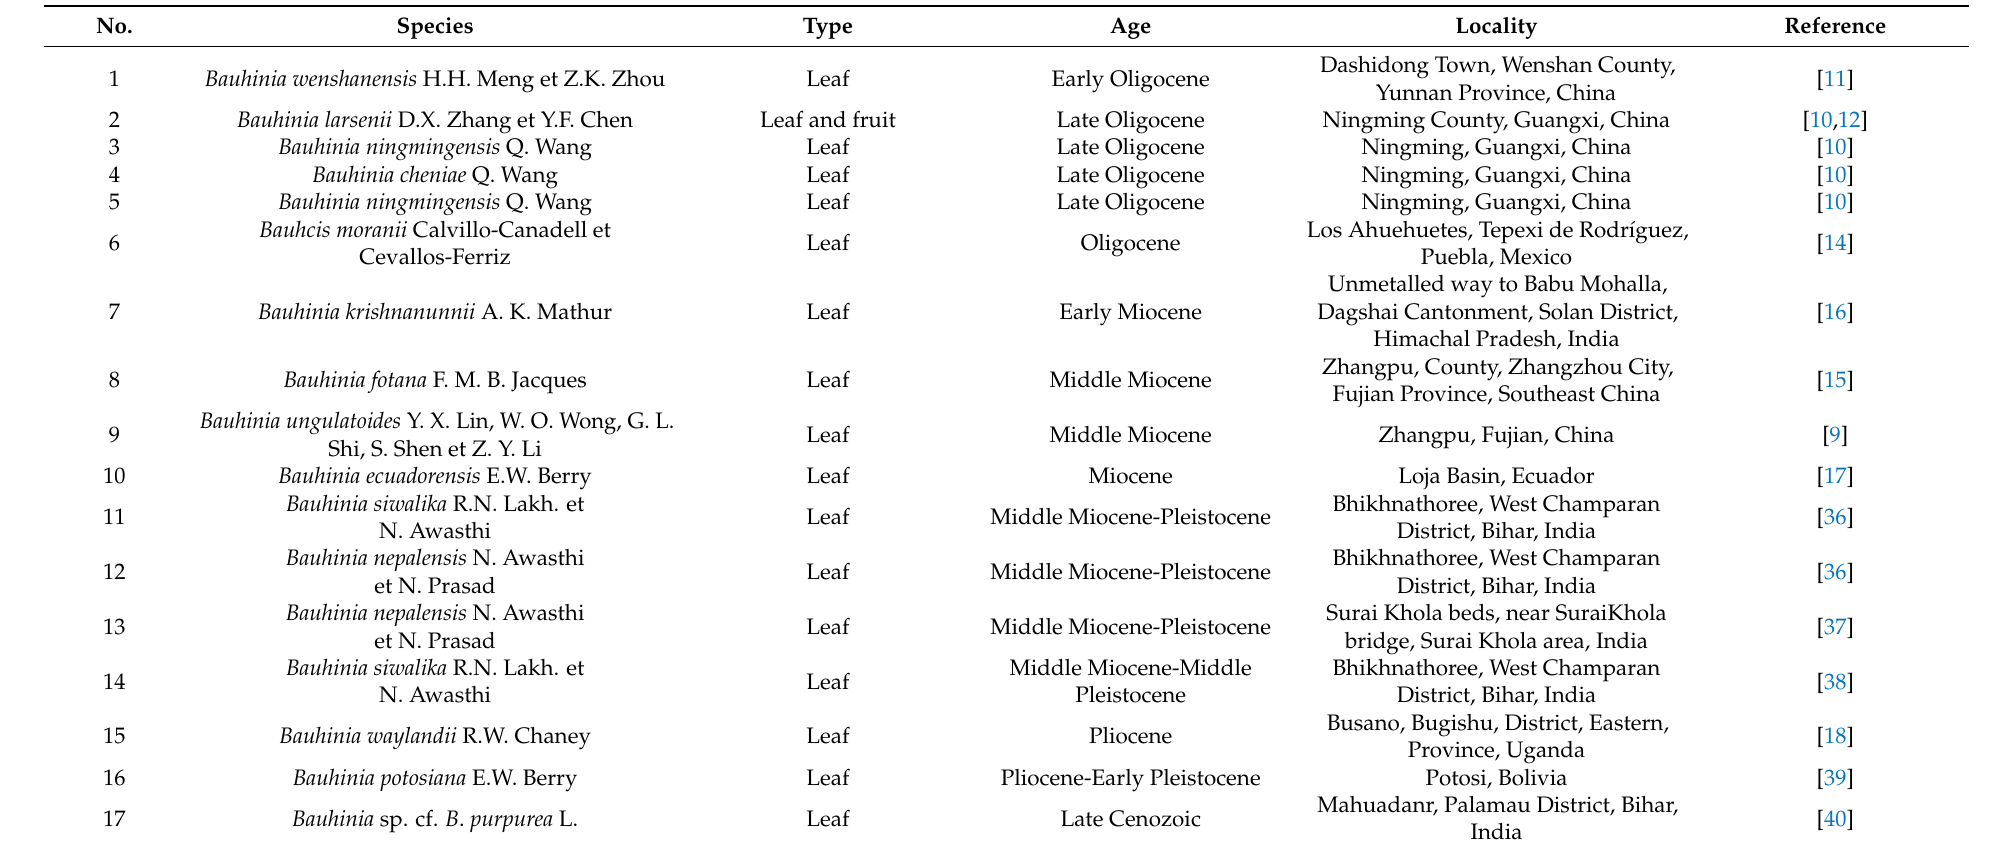
Table 1. Leaf and fruit fossil records of Bauhinia